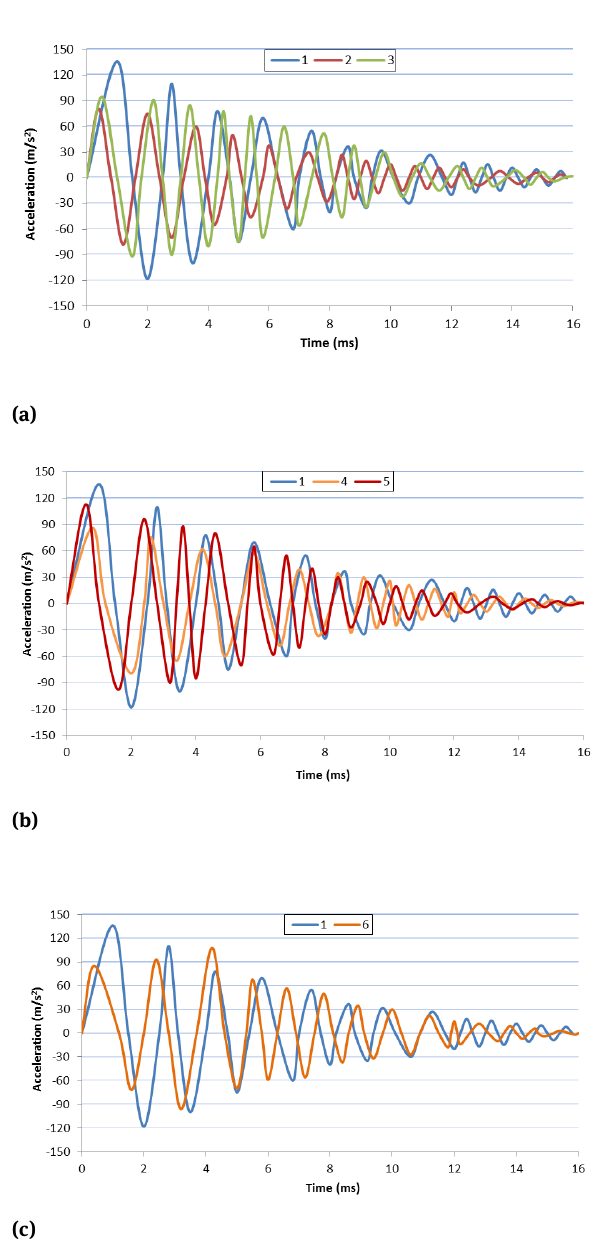
Figure 14: Variation of acceleration with the time for free vibration based composites containing: (a) (1) Al 6063; (2) Al 6063 + 5% MA; (3) Al 6063 + 5% MCA; (b) (1) Al 6063; (4) Al 6063 + 5% NFC; (5) Al 6063 + 5% SA; (c) (1) Al 6063; (6) Al 6063 + 5% MA + 5% MCA + 5% NFC + 5% SA.